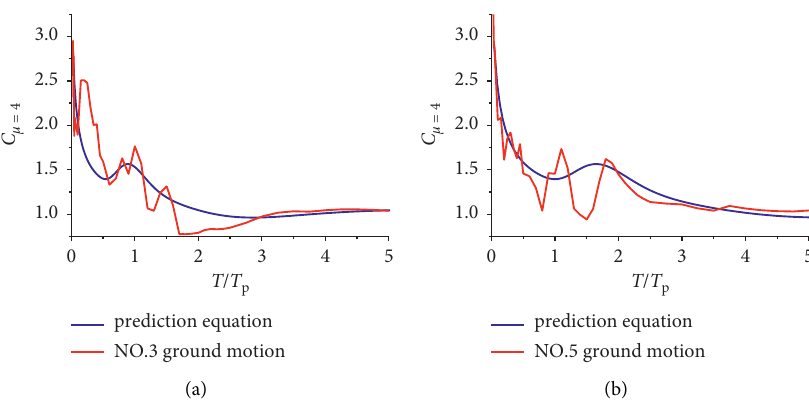
Figure 16: Comparison of the inelastic displacement ratios estimated by the proposed prediction equation to those of (a) no. 3 ground motion and (b) no. 5 ground motion of Table